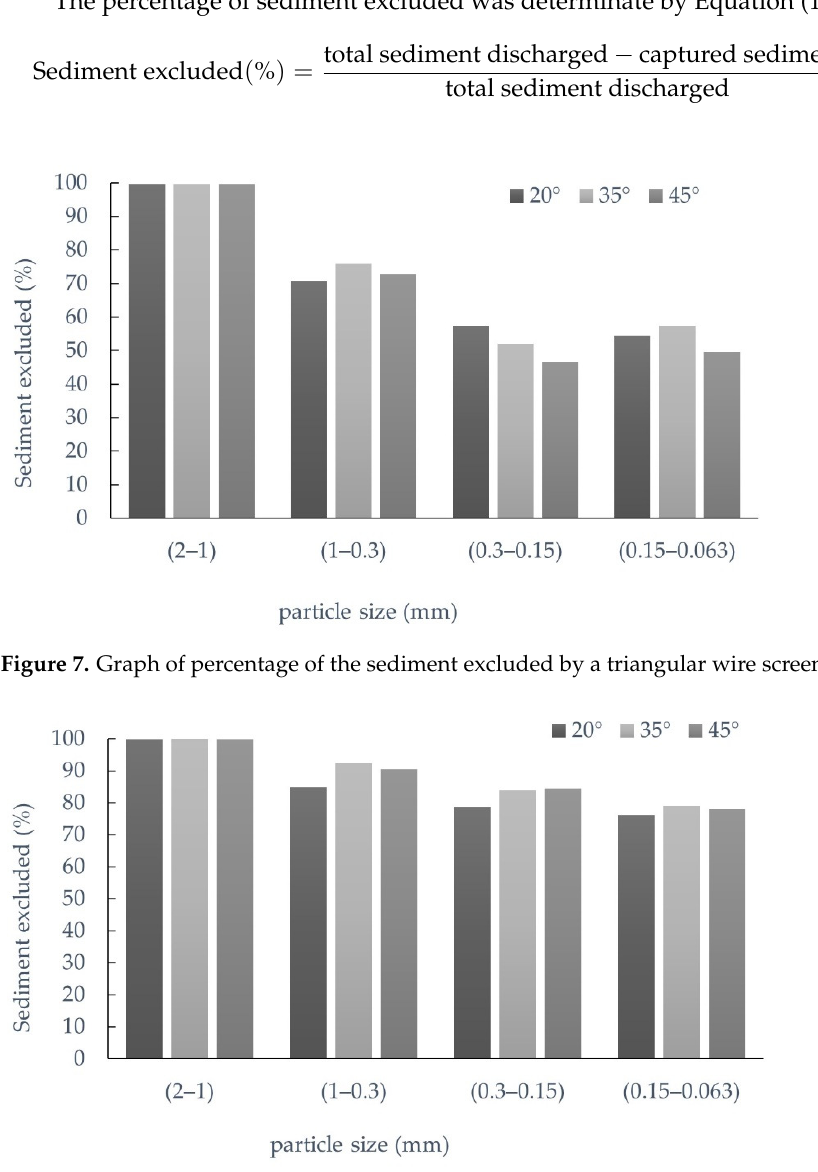
Figure 8. Graph of the percentage of sediment excluded by a circular wire screen.